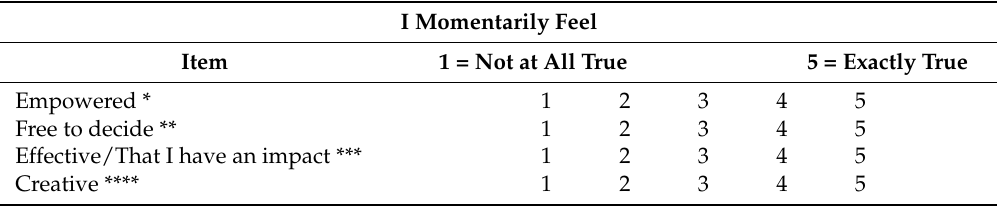
Table A2. Experience of Creation Scale ( ECS ; English Translation;